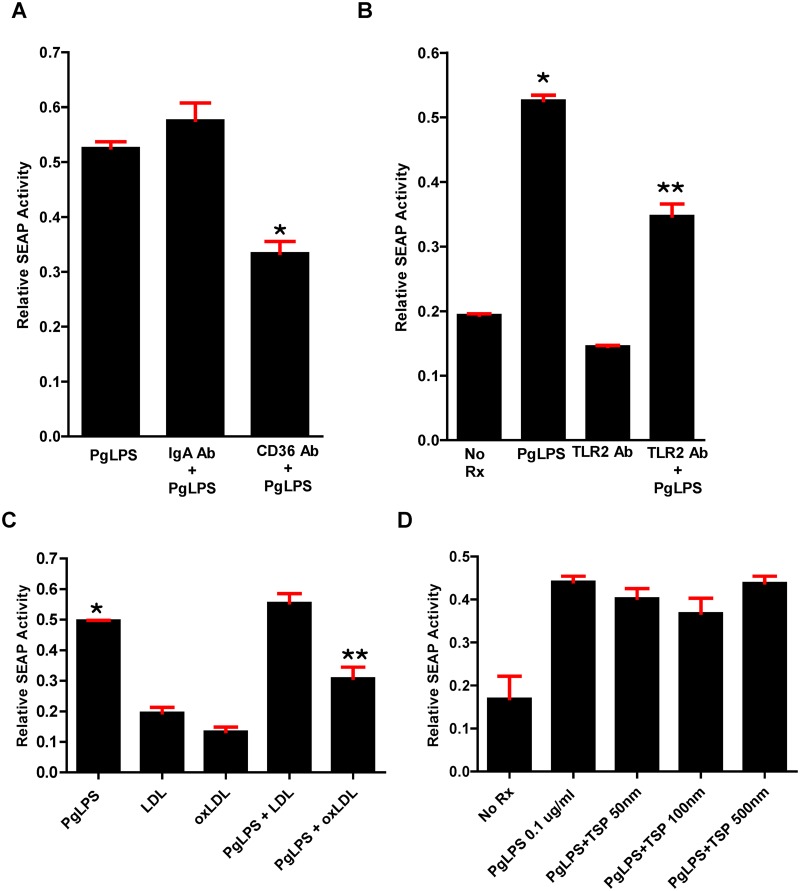
PgLPS induced NFκB activation is inhibited by antibody to CD36/SR-B2 and TLR2, and oxLDL.NFκB activation was assessed in RAW-Blue cells containing a secreted alkaline phosphatase (SEAP) reporter construct. A. Monoclonal antibody to CD36/SR-B2, but not control IgA significantly inhibited NFκB activation in response to PgLPS. One way ANOVA, p< 0.0001. Bonferroni’s Multiple Comparison Test, p<0.05. *vs all groups. Experiment was performed in triplicate and repeated three times. B. Polyclonal antibody to TLR2 significantly inhibited NFκB activation in response to PgLPS. Antibody alone could not activate NFκB at the concentration added. One way ANOVA, p< 0.005. Bonferroni’s Multiple Comparison Test, p<0.05. *,** vs all groups. Experiment was performed in triplicate and repeated twice. C. OxLDL but not LDL inhibits NFκB activation in response to PgLPS. One way ANOVA, p< 0.005. Bonferroni’s Multiple Comparison Test, p<0.05. * vs all groups except PgLPS+LDL; ** vs all other groups except LDL. Experiment was performed in triplicate and repeated twice. D. Pre-treatment with thrombospondin-1 (TSP) had no effect on NFκB activation in response to PgLPS. One way ANOVA, p> 0.05. Experiment was performed in triplicate and repeated twice.